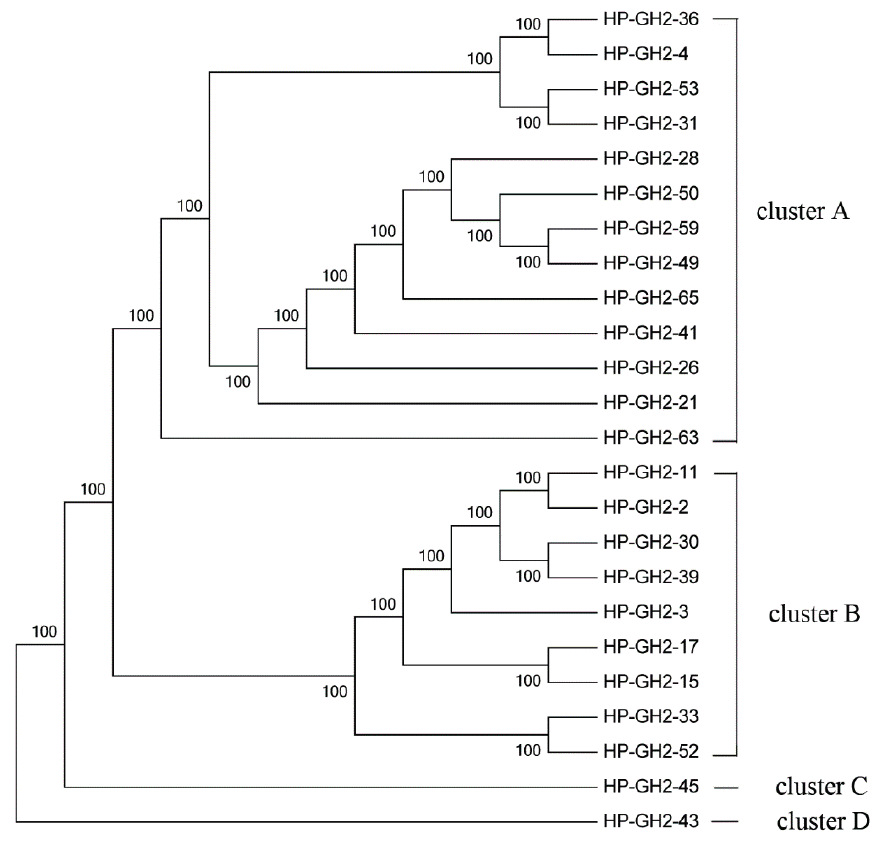
Figure 4. Maximum Likelihood phylogenetic tree of the GH2 amino acid